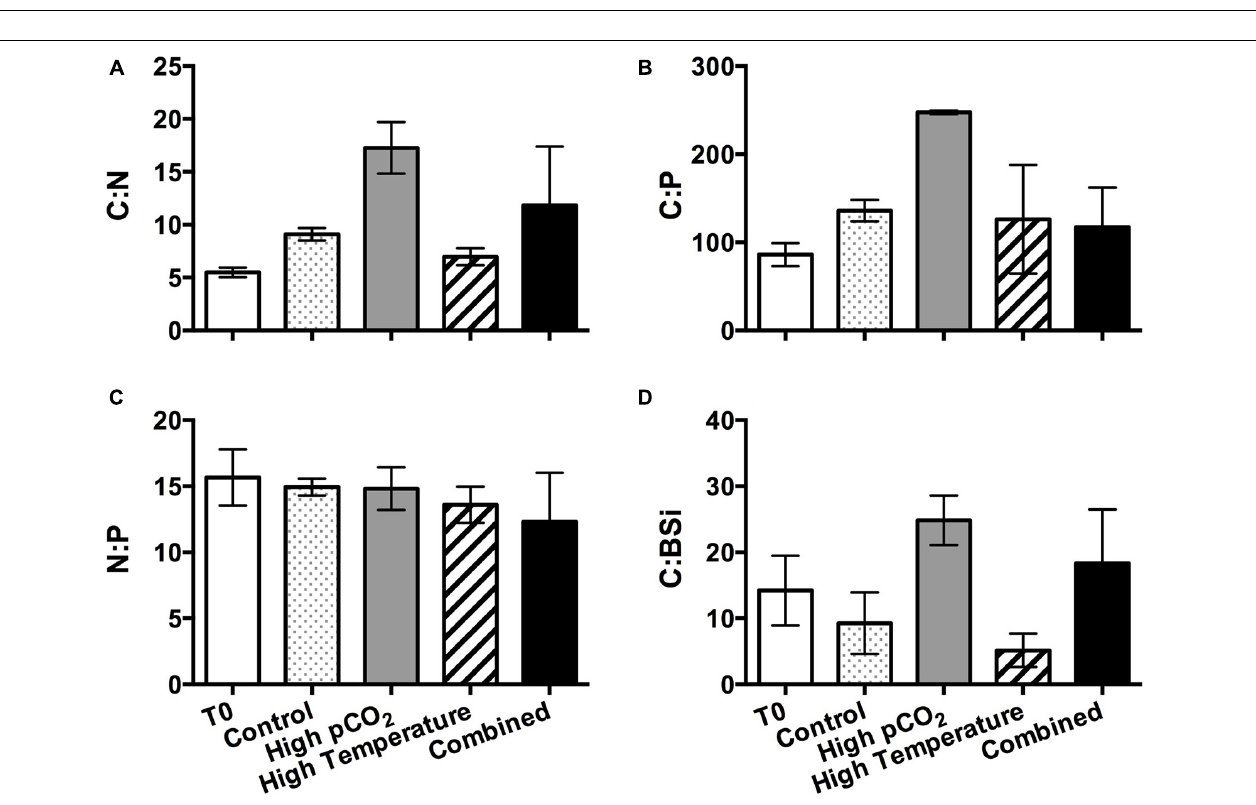
FIGURE 6 | Elemental molar ratios in the beginning of the incubation (T0) and in the four experimental treatments on the final sampling day: (A) particulate organic carbon to particulate organic nitrogen ratio (C:N); (B) particulate organic carbon to particulate organic phosphorus ratio (C:P); (C) particulate organic nitrogen to particulate organic phosphorus ratio (N:P); and (D) particulate organic carbon to biogenic silica ratio (C:BSi). Values are the means and error bars are the standard deviations of